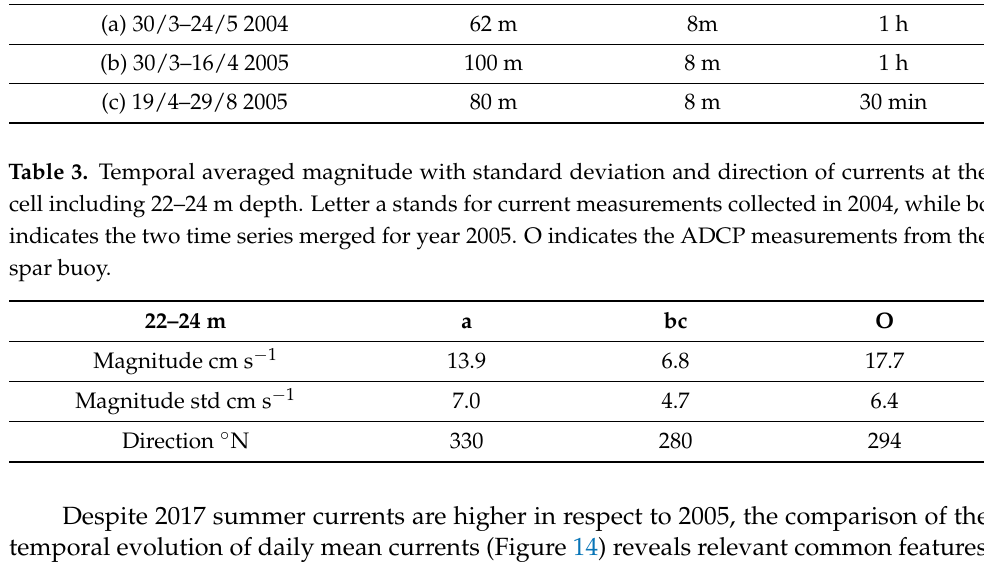
Table 2. Period of measurements and settings of the ADCP measurements used for the compari- son.